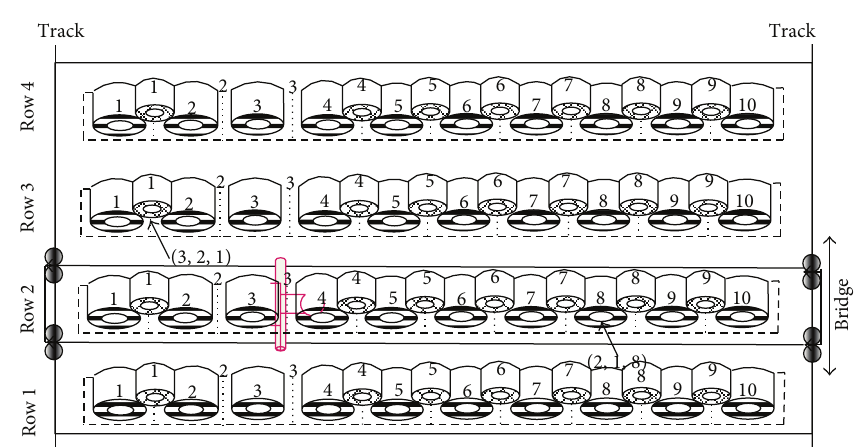
Figure 2: Top view of an area in steel coil